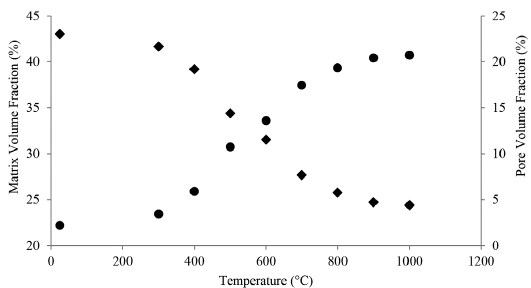
Figure 4. Graph of matrix volume fraction (  ) and pore volume fraction (  ) as a function of heat treatment temperature, data extracted from Table 1 .